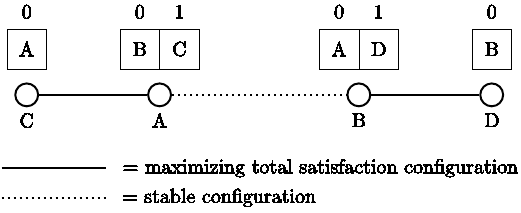
Figure 2. Example network exhibiting different stable and maximizing total satisfaction